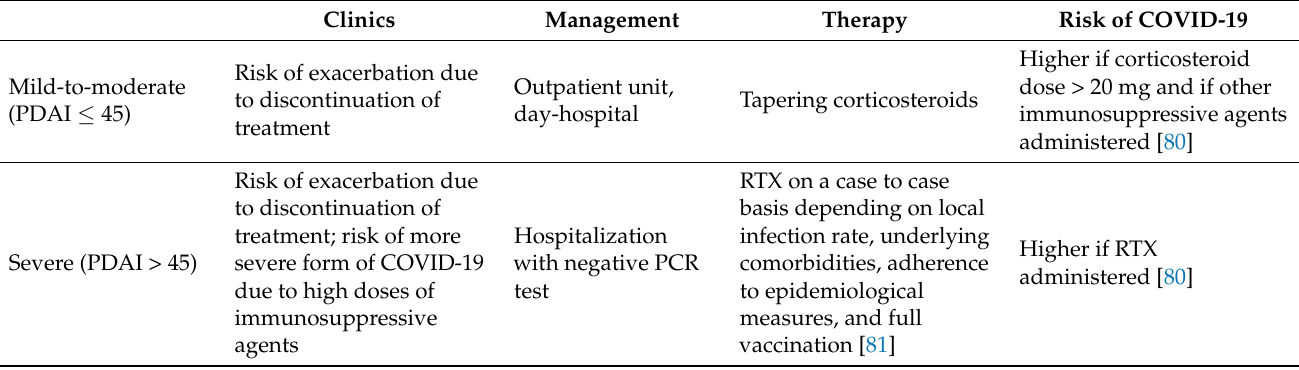
Table 3. Pemphigus during the COVID-19